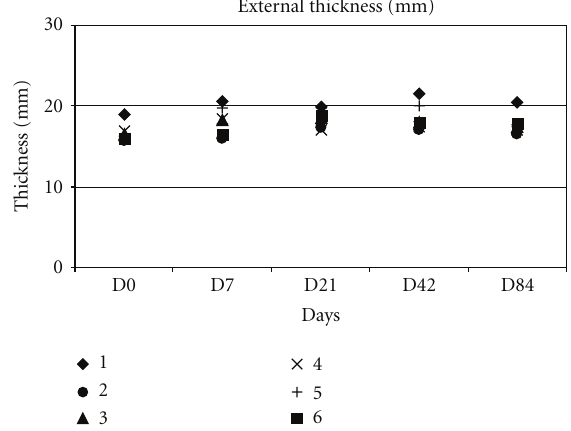
Figure 4: Change in external width. Figure 5: Change in external thickness. Table 1: A global functional score was calculated based on lameness at walk and trot and normalized (score of lameness at walk + score of lameness at